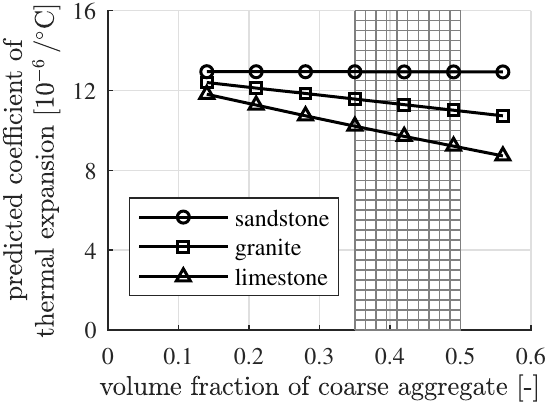
Figure 5. Dependence of the thermal expansion coefficient of concrete on the type and the volume fraction of the coarse aggregates, with RH = 50%, f cp = 0.30 and w / c =